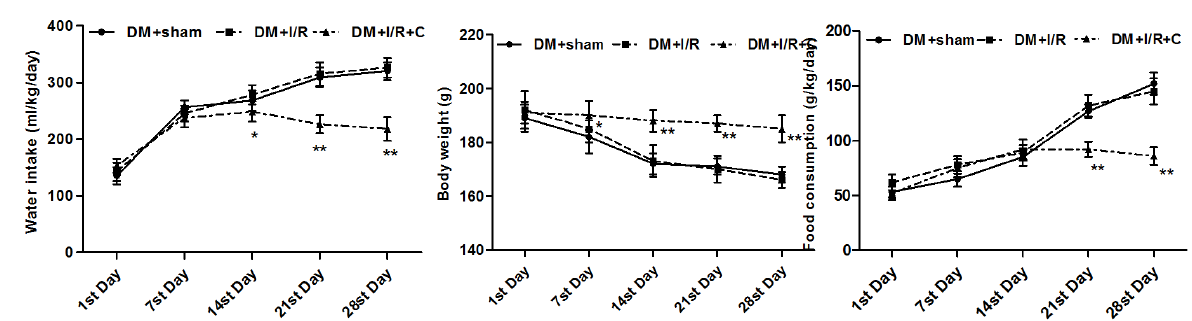
Figure 1. Efects of catalpol on water intake, body weight, and food consumption in diabetic rats. * P < 0.05 versus the DM+I/R group; ** P < 0.01 versus the DM+I/R